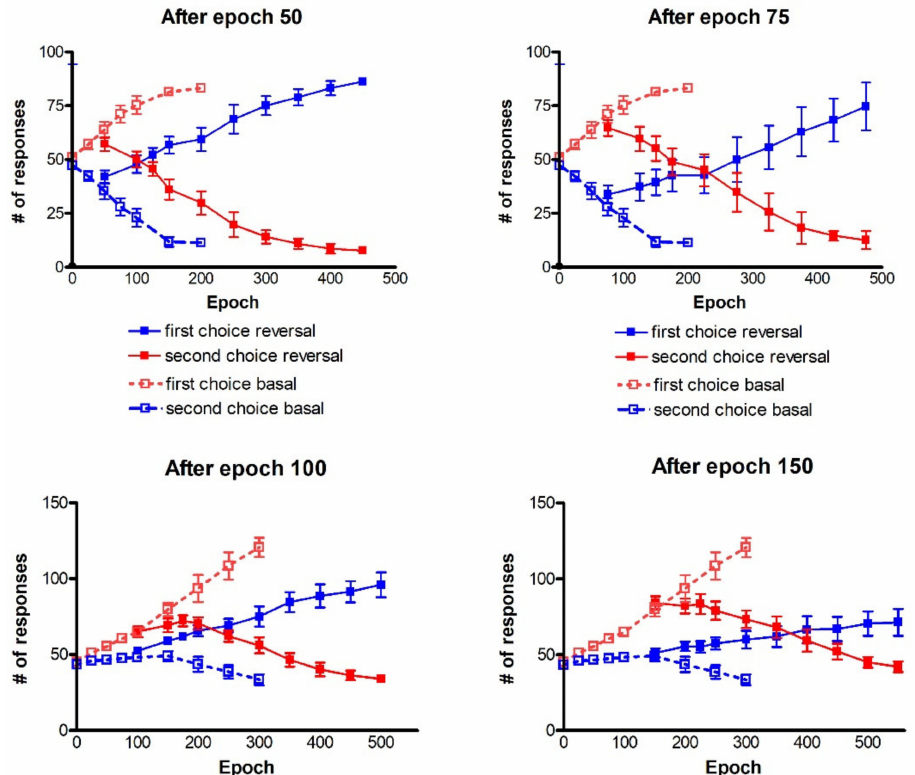
Figure 11. Results of the tests performed after basal training and a reversal learning, obtained by using the Equations (1)–(3) to automatically compute the phasic changes in the dopaminergic input as a function of the expected reward. The panels in the upper row refer to a two-choice task (100 trials per each test) and should be compared with the curves in Figure 6. The panels in the bottom row refer to a four-action task (200 trials per each test) and should be compared with the curves in Figure 9. The results show that the model can perform the basal and reversal learning quite well in case of a two-action task (upper panels). In case of a four-action task, the model can perform the basal task and the reversal task after 100 epochs quite satisfactorily. The reversal task after 150 epochs is still difficult, but significantly improved compared with the one in the right panel of Figure 9. The complete pattern of the synapses, both during the basal and the reversal phase, is shown in the Supplementary Materials